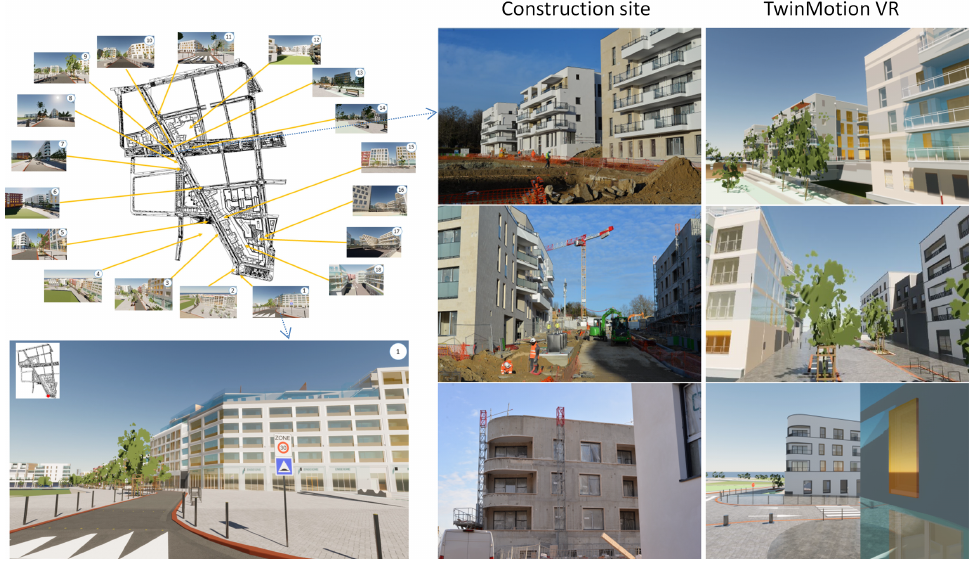
Figure 10. TwinMotion visualizations with the reality of the construction site. Table 1. Prototype size and specificity of archviz TwinMotion